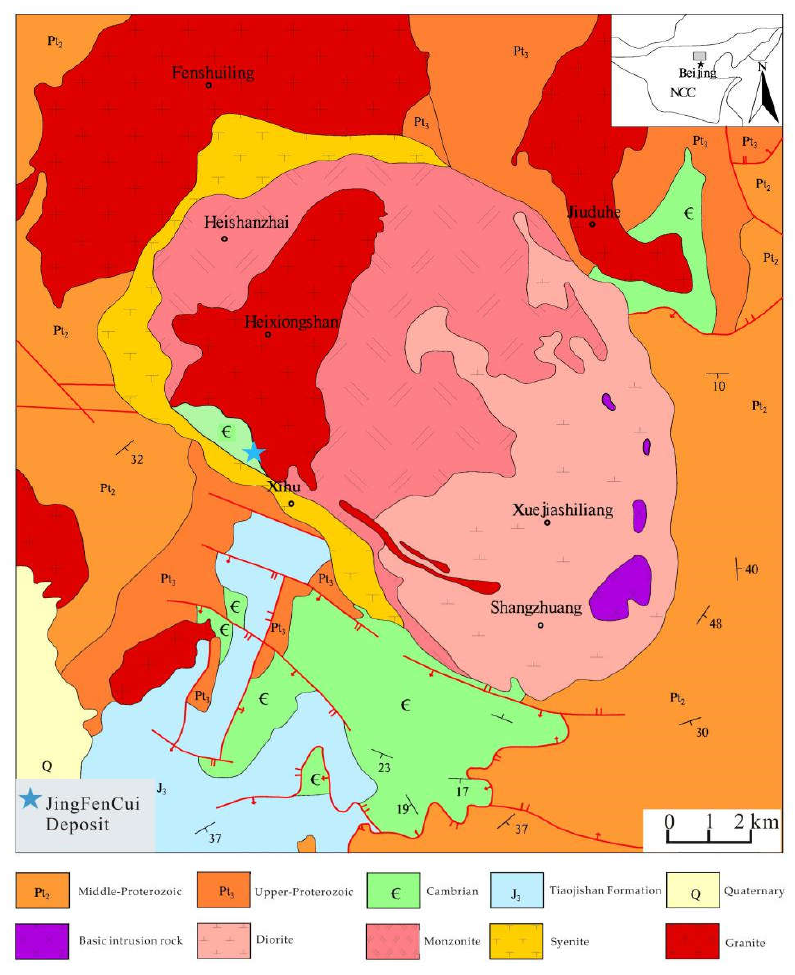
Figure 1. The regional geological map of JingFenCui deposit (modified after Di, Y.-L. [4])